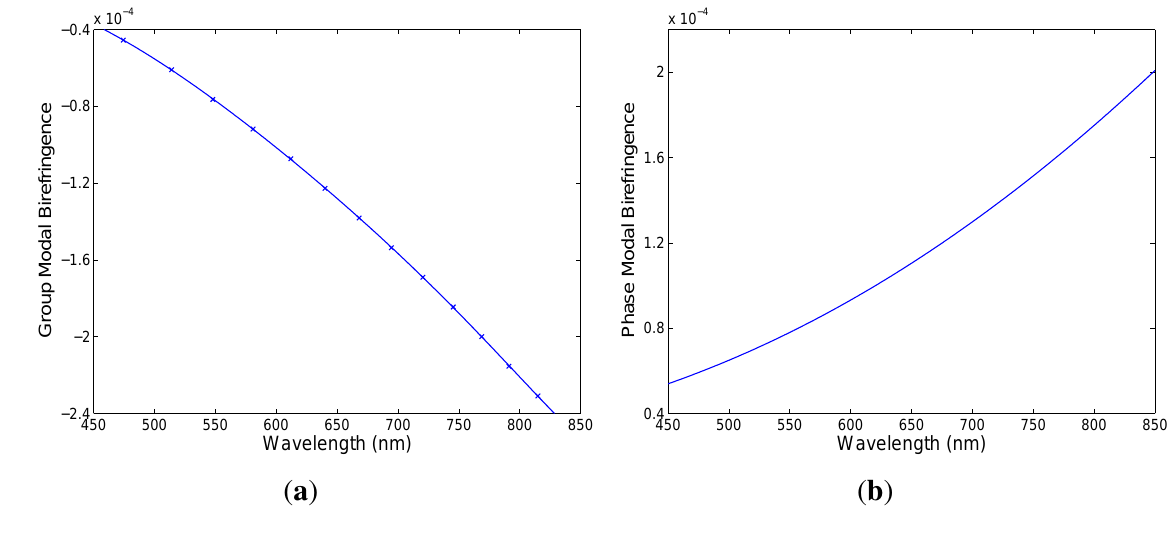
Figure 4. Measured spectral dependence of the group ( a ) and phase ( b ) modal birefringence in the FUT. The line crossing the markers is a polynomial